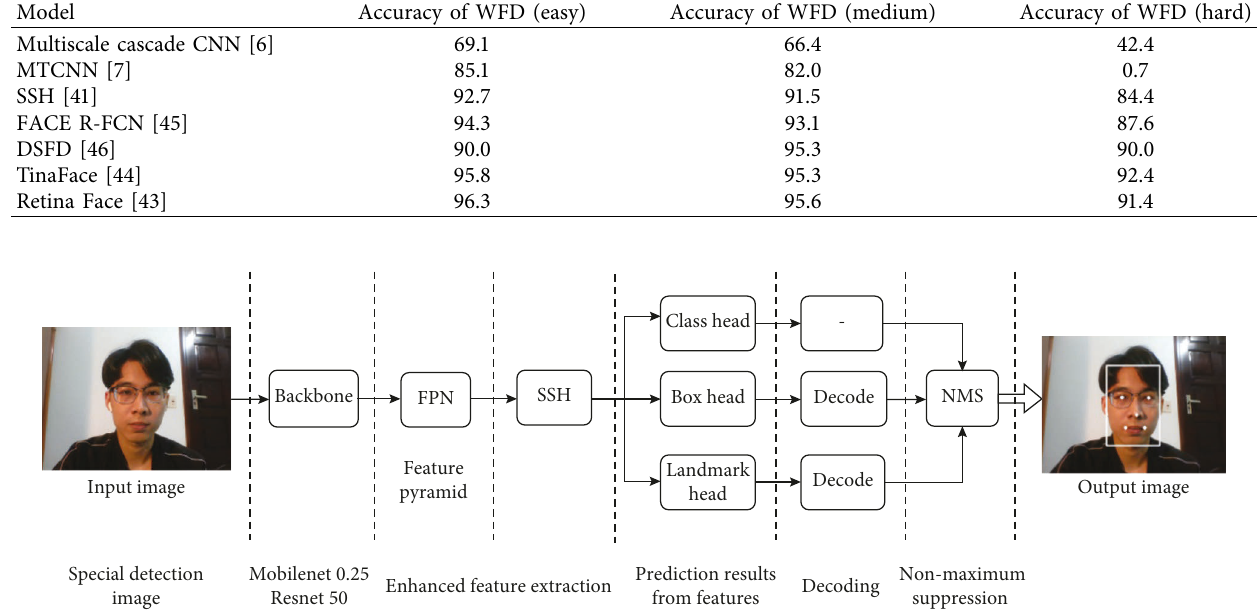
Figure 11: Processing steps in the Retina Face model.